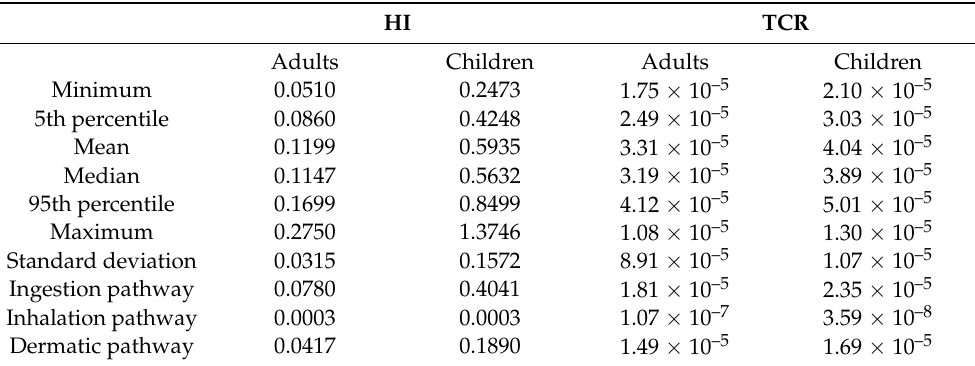
Table 5. Health risk assessment of metals in soils.